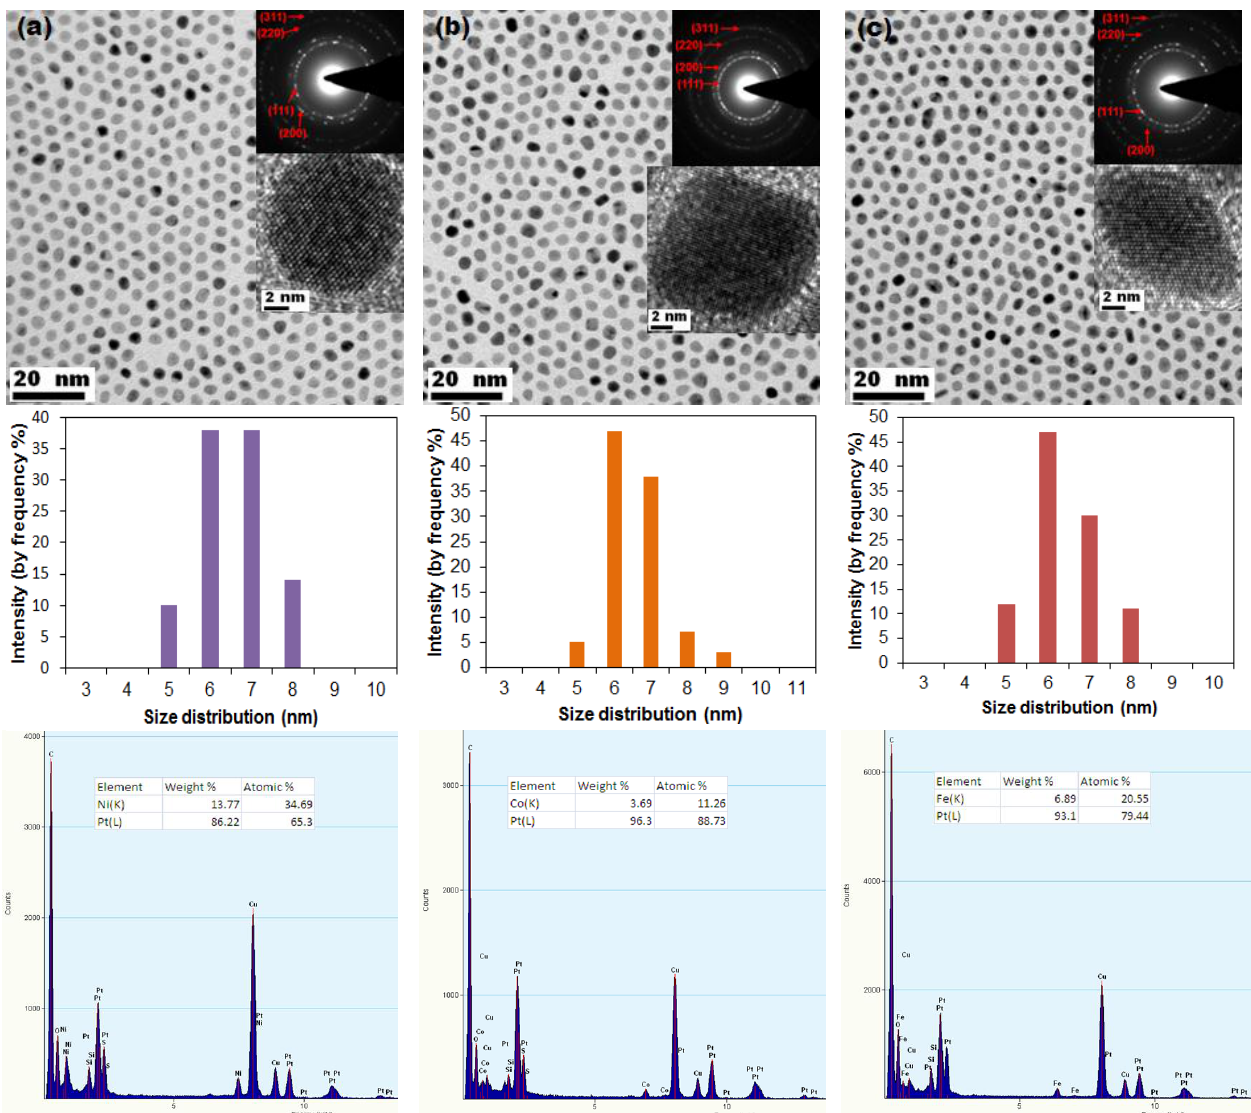
Figure 1. Bright-field TEM images of ( a ) PtNi ( b ) PtCo and ( c ) PtFe nanoparticles synthesized by the simultaneous reduction of metal precursor salts using TBAB as the reducing agent in the presence of OAm, TOA and ODA in BE. The inserts show the FCC electron diffraction patterns and HRTEM images from the corresponding samples. Also shown are the corresponding particle size distribution histogram and EDS spectrum of the nanoalloys.